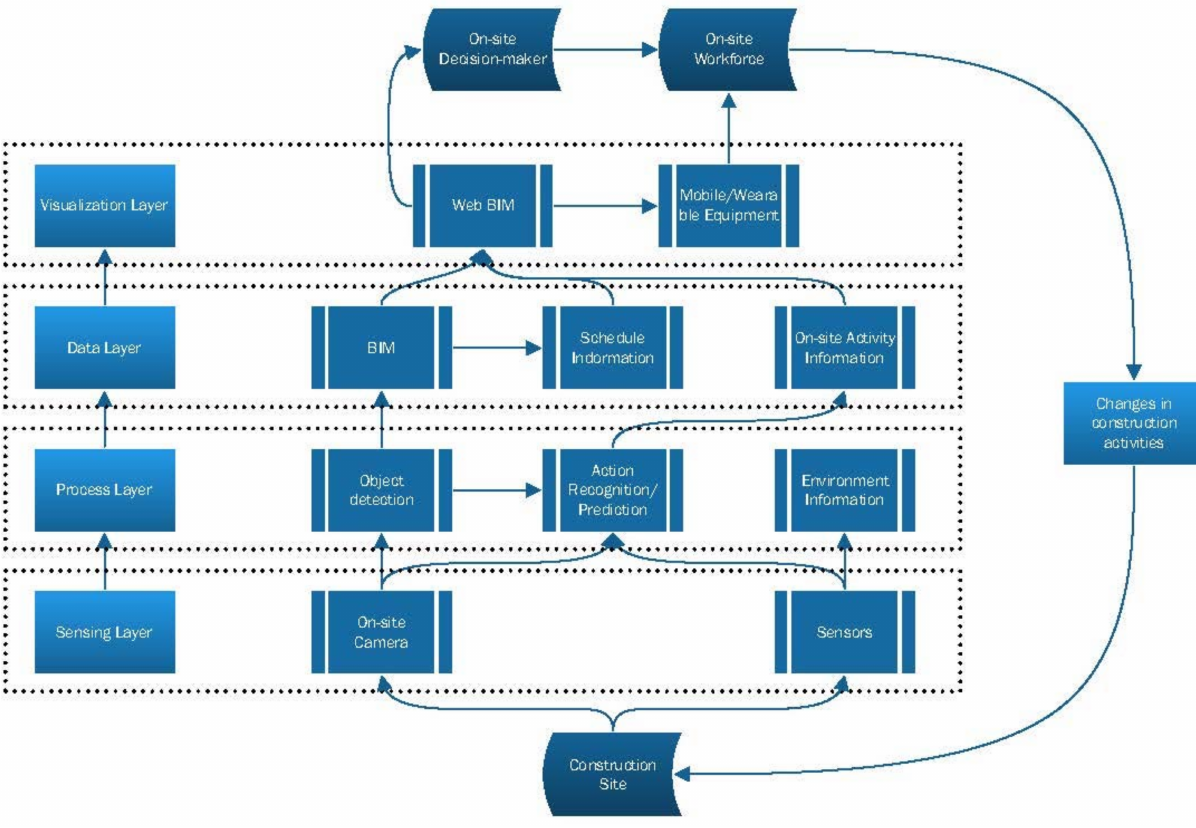
Figure 10. Four layers of the construction process